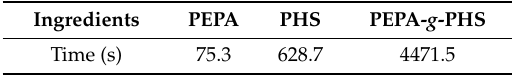
Figure A1. ( a ) FT-IR spectra and ( b ) Optical photographs of 12-HSA, PHS, PEPA, and PEPA- g -PHS. Table A1. The Tu-4 cup viscosities of PEPA, PHS and PEPA- g -PHS.